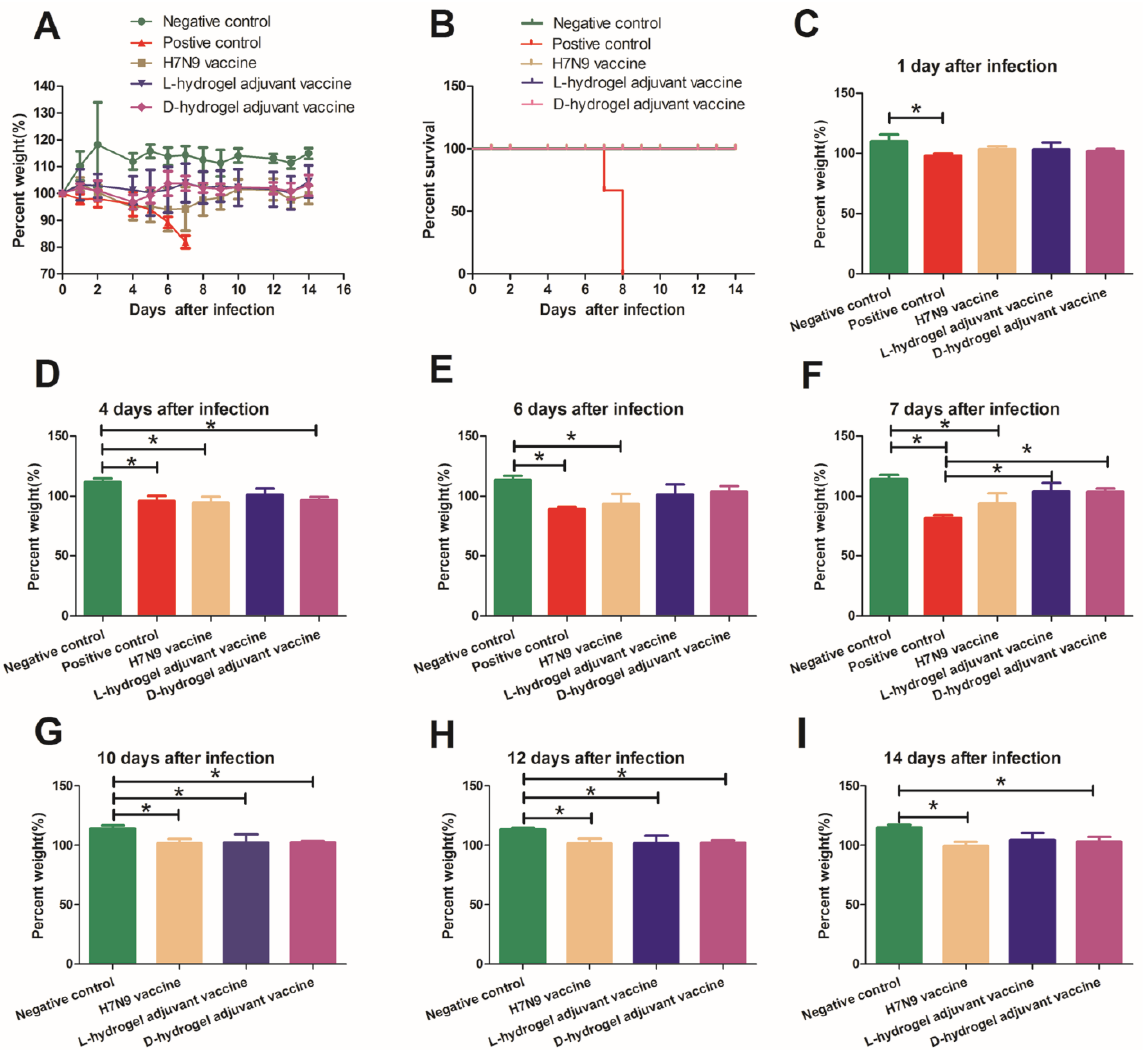
Figure 2. Weights and survival of mice infected with the H7N9 virus and treated with various vaccines. ( A ) Weight variations of mice infected with H7N9 virus (50 μ L 10 6 TCID50). Groups of mice were immunized with the indicated vaccines on day 0 and 14 before intranasal virus challenge. The percent weight was calculated as the percentage of weight on indicated days versus the weight on initial day (the day when the mice were inoculated with H7N9 virus). ( B ) The survival curve of the five groups. ( C – I ) The percent weight calculated at 1, 4, 6, 7, 10, 12, and 14 days after infection, respectively. Data are shown as the mean ± SD for the indicated sample sizes. The mean values with error bars representing one standard deviation. An asterisk (*) represents a p value 0.05.